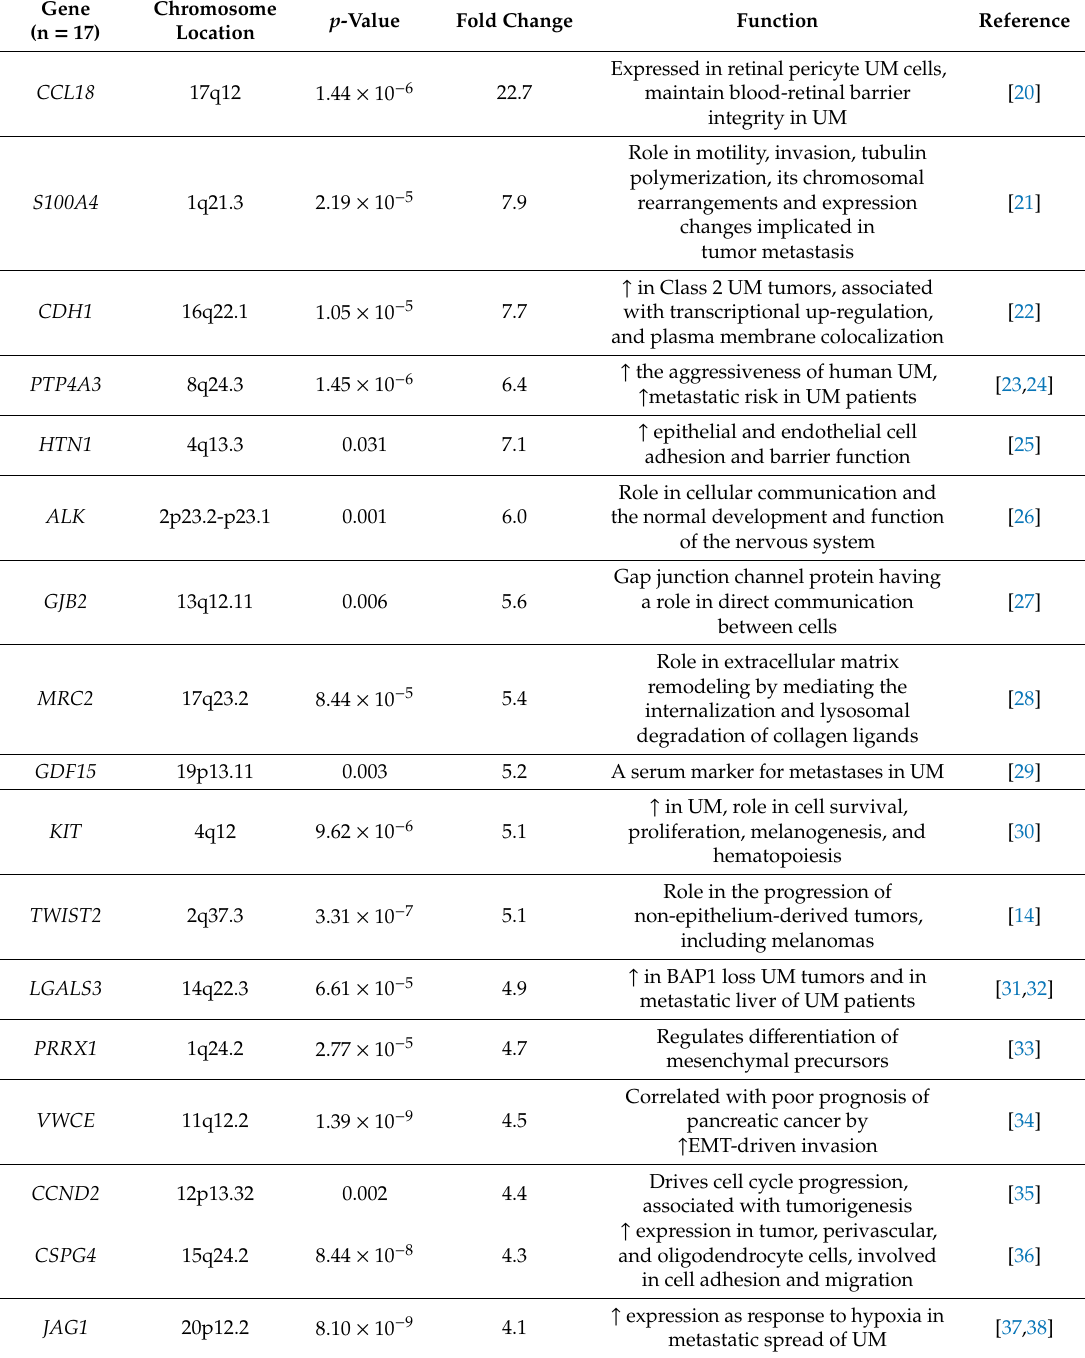
Table 3. A partial list of up-regulated EMT-associated genes in M3